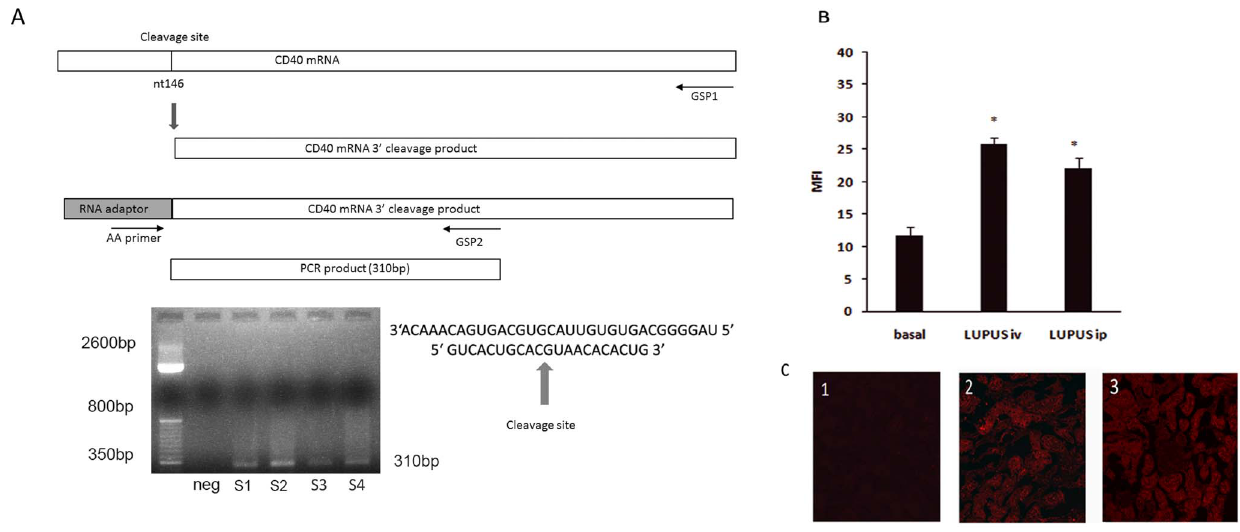
Figure 5. siRNA-mediated cleavage of CD40 mRNA in vivo. Confocal fluorescence and brightfield images of siRNA internalization in DC. A) Schematic representation of the CD40 mRNA illustrating siRNA cleavage sites and RACE strategy to detect cleavage product. Agarose gel of RACE–PCR amplification showing specific cleavage products in different lupus nephritis samples (S1 and S2), and in vitro DC culture (S3 and S4). B) Quantification of renal internalization of Chol-siRNA administered iv/ip in lupus mice. C) Representative kidney photomicrographs (x400) of 1- Basal auto fluorescence, 2- iv administration, 3- ip administration. Data are expressed as mean 6 SEM of four separate experiments.*p , 0.05 vs basal.